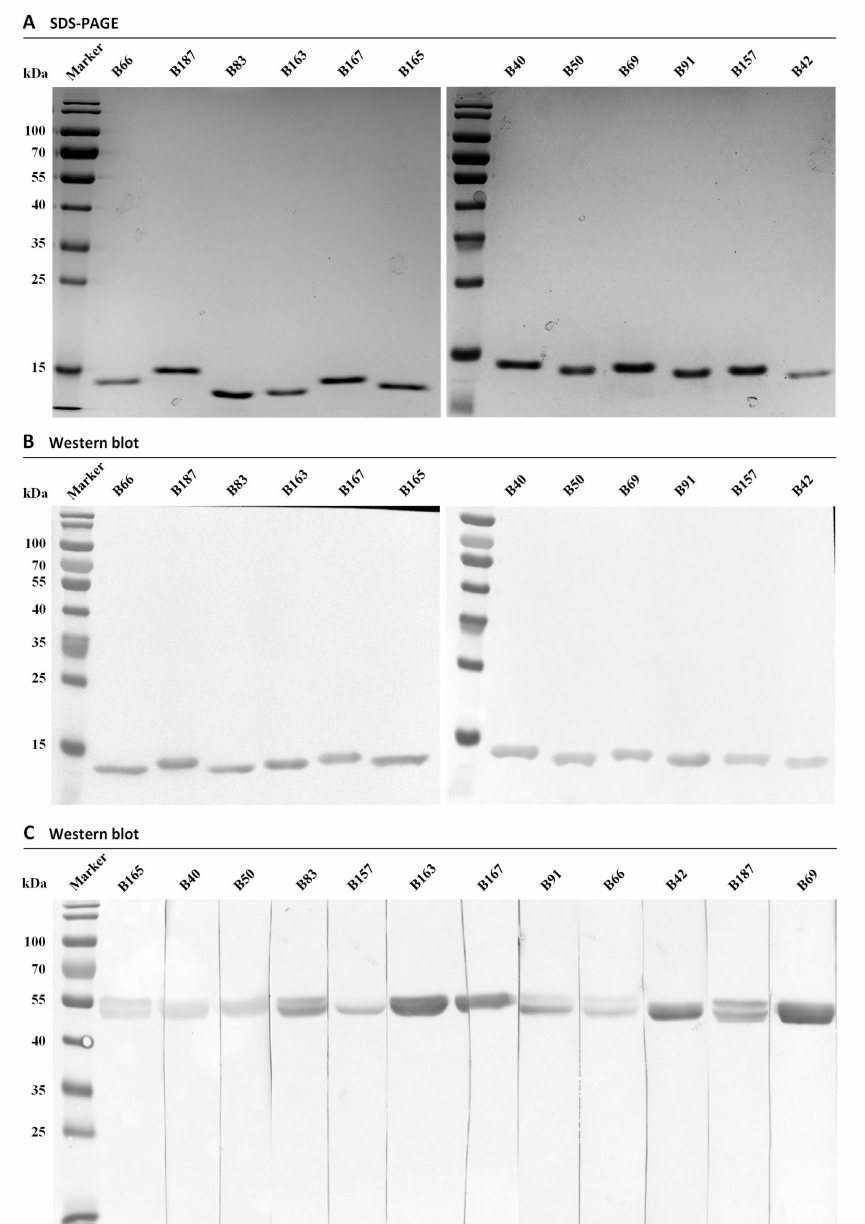
Figure 3. Confirmation and specificity analysis of selected Nbs. ( A ). The purity of Nbs with His- and HA-tag after expression and purification by IMAC and SEC was evaluated by SDS-PAGE. ( B ). The identify of His- and HA-tagged Nbs was evaluated by western blot after staining with mouse anti-His IgGs. ( C ). Antigen specificity of the Nbs was evaluated by western